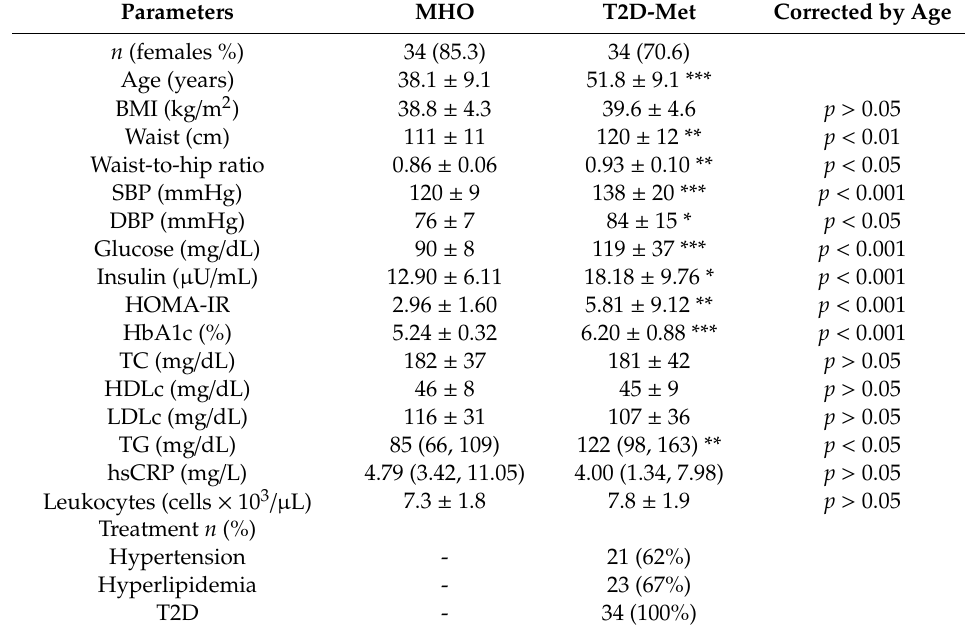
Table 1. Anthropometric and biochemical parameters of the study